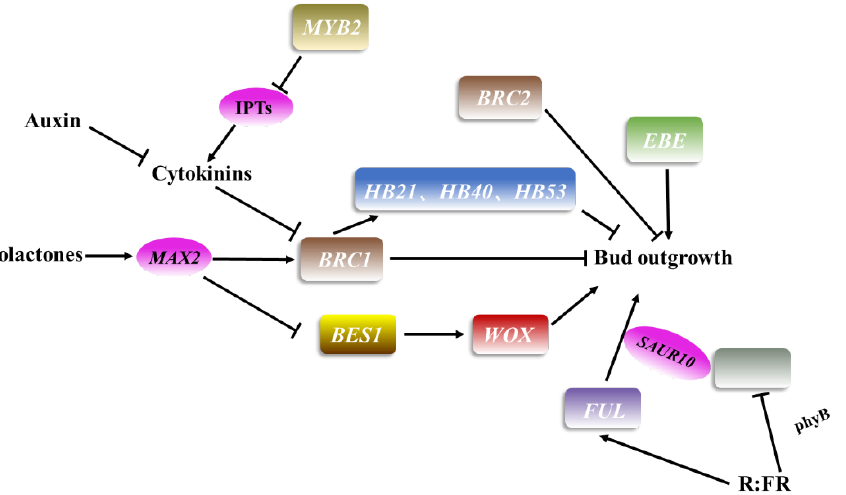
Figure 3. Patterns of transcription factors involved in regulating axillary meristem growth in Ara- bidopsis thaliana . The rectangular box represents transcription factors, the same color represents the same family, and ellipses represent genes other than transcription factors. The arrow and rough line represent positive and negative regulation, respectively.